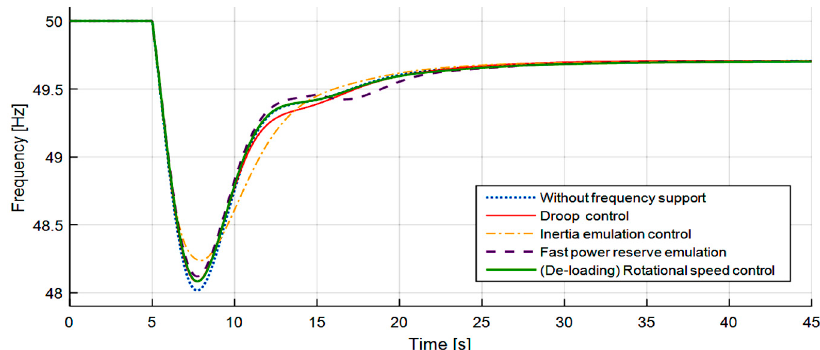
Figure 12. Frequency response for different controllers in low wind speed case after frequency disturbance.